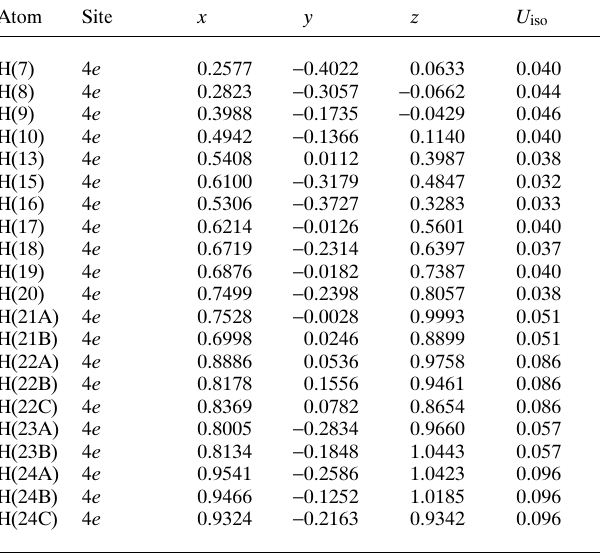
Table 2. Atomic coordinates and displacement parameters (in Å 2 )